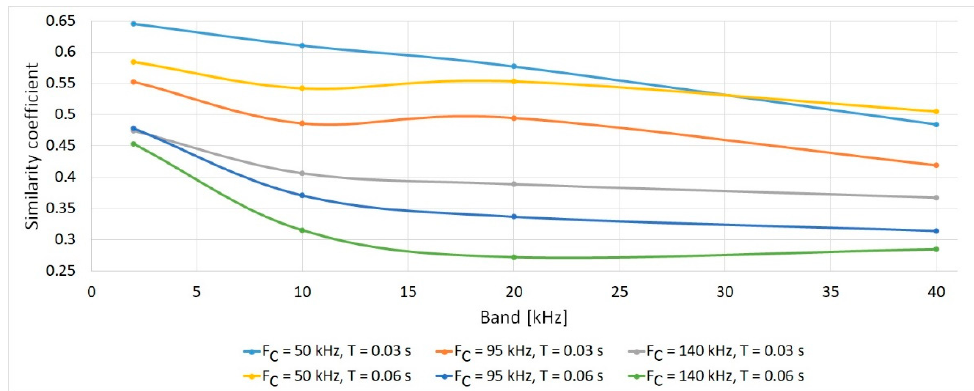
Figure 8. Effect of bandwidth B for different center frequencies, F C , and chirp duration, T , on the